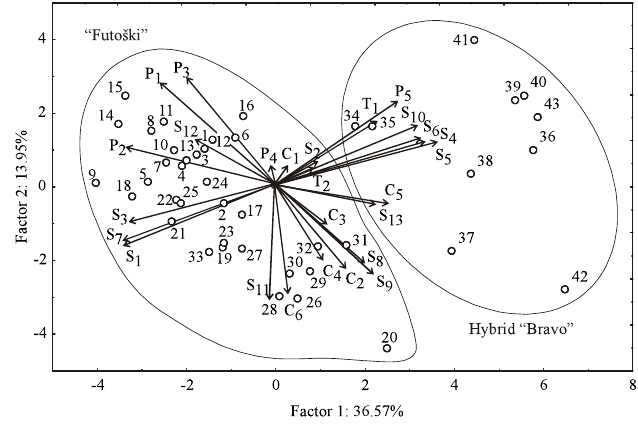
Tab. 3: Sensory evaluation of raw cabbage, cultivar “ Futoški “ and hybrid “ Bravo “ Shape Violet Coverage Color of Leaf Leaf Leaf with outer venation thickness elasticity section color density presence leaves leaves color Codes S 1 S Cultivar “ Futoški ”, SS=0.85, N=33 samples Average 0.84 St. dev Min. Max. Variance Hybrid “ Bravo ”, SS=0.36, N=10 samples Average St. dev Min. Max. Variance